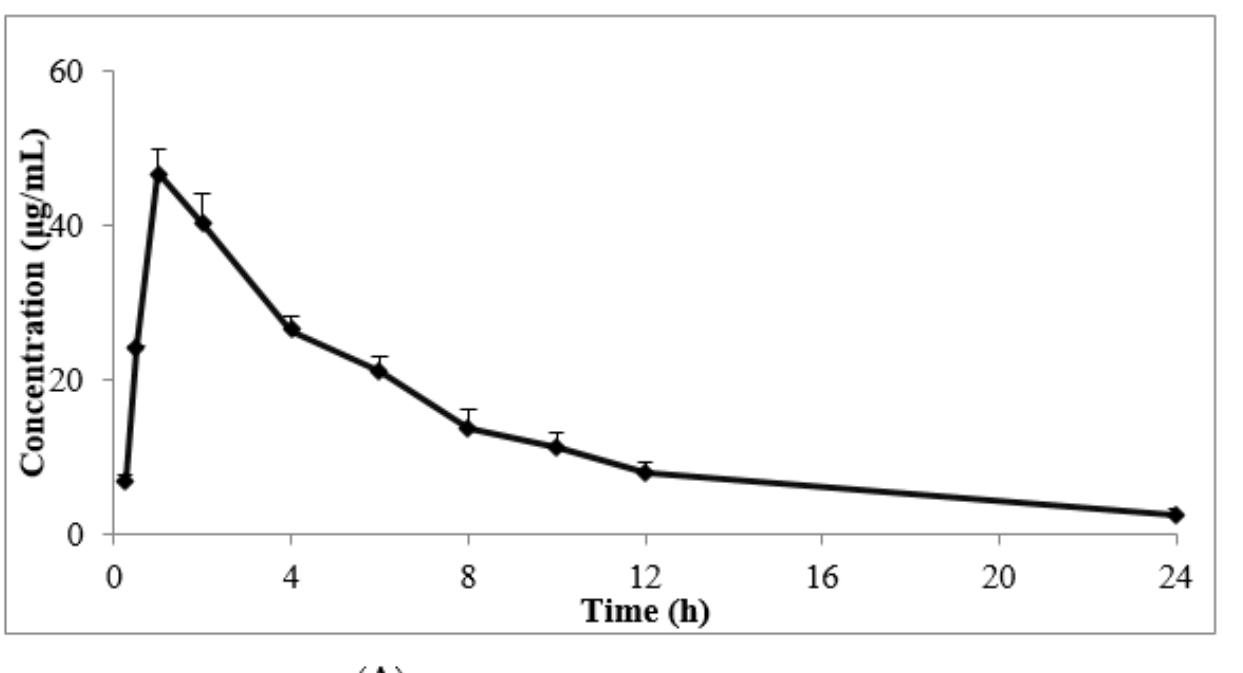
Figure 8. The mean drug–time curves of skin tissues after topical administration of CE-NE ( A ) and ointment ( B ) in KM mice. ( n = 5). 3. Discussion The results of drug release in vitro showed that CE-NE had good drug release char- acteristics in the buffer of pH4.0 (Figure 3), and the free CE rapidly increased to 36.7% within 6 h, compared with 22.6% in the buffer of pH 7.8. It can be concluded that the acidic environment is for the medium solution to enter the nanoparticles and dissolve the drug. The data revealed the sustained release profile of CE fitted best to First-order kinetics equation, and the equation of goodness-of-fit is 0.9854, close to 1 (Table 1). The drug is released quickly at first, and then slowly, which may be due to the adsorption of CE, on the surface of the nanoparticles, so the drug is released faster, so that more drugs can be released quickly after reaching the target site, reaching a higher concentration. With the progress of release, the drug encapsulated in the nanoparticles is gradually released be- cause of the dissolution of the carrier material, and the drug release rate is relatively slow to maintain the efficacy, which is beneficial to improve the drug utilization rate. Hair follicles undergo a cycle of anagen, catagen, and telogen, and re-arrangement of the skin vasculature occurs during hair cycling [20–22]. Minoxidil, as a chemical drug, has been used to stimulate hair growth for many years [23]. However, its general use is limited